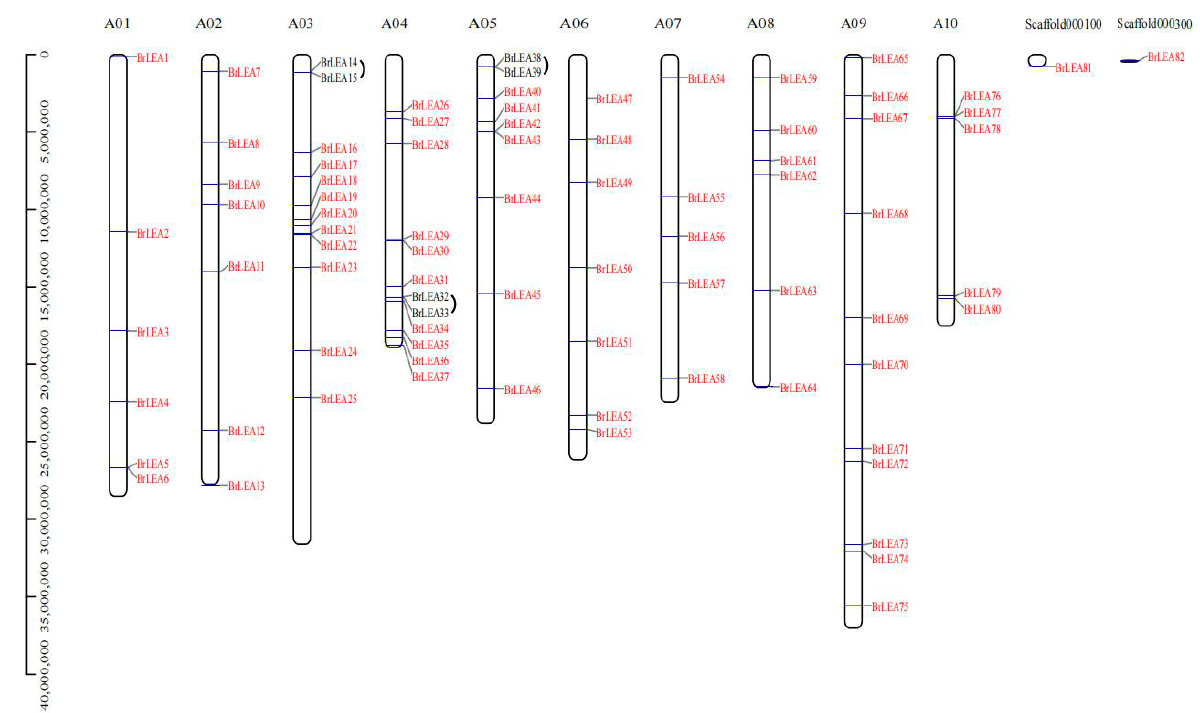
Figure 4. Chromosome localization of the BrLEA gene family.